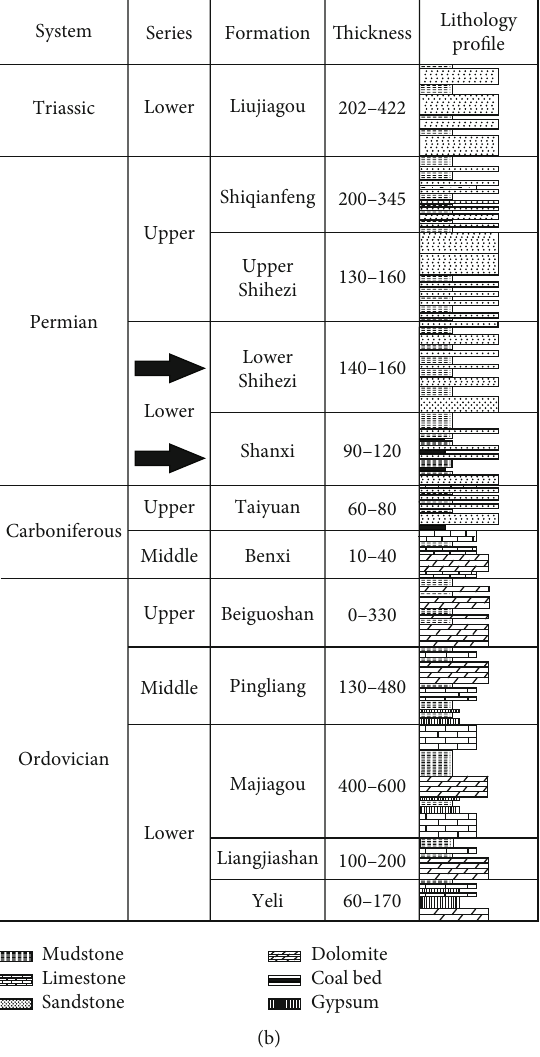
Figure 1: (a) Location map of the research area with inset map of the Ordos basin region (upper right) and (b) stratigraphic column from Ordovician Majiagou formation to Triassic Liujiagou formation in the northern Ordos basin [24,